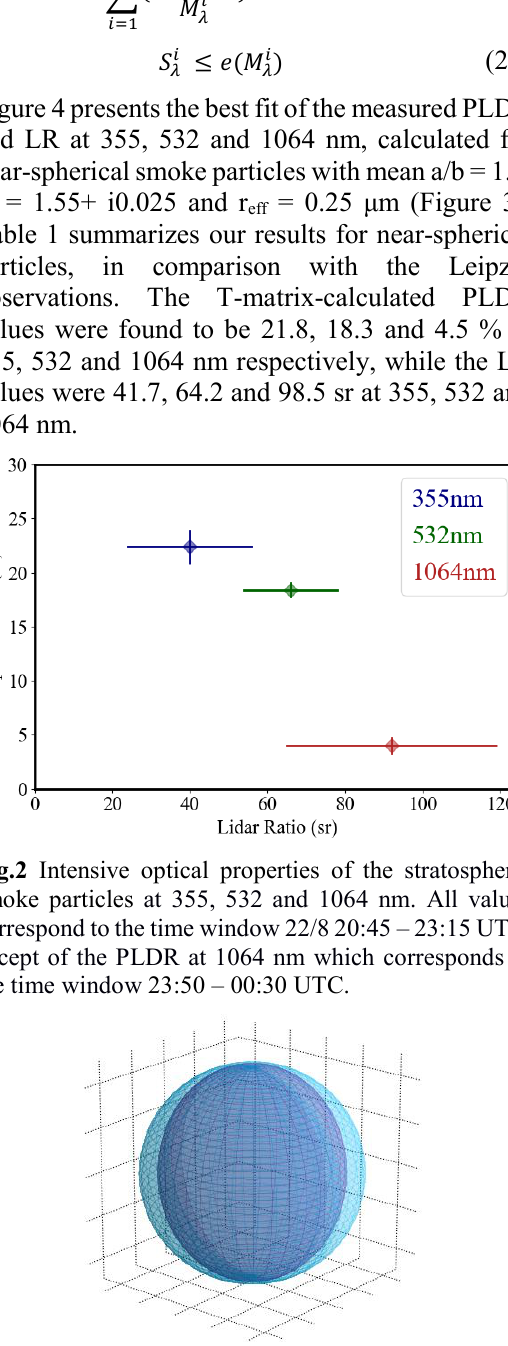
Fig. 3 Near spherical particle (a/b = 1.4, r eff = 0.25 μm) found to reproduce the observed PLDR and LR values at all measurement wavelengths.